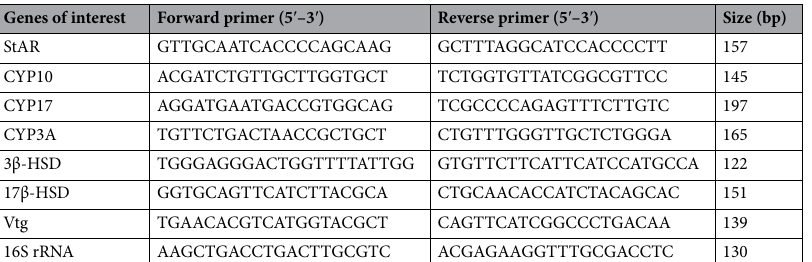
Table 1. Gene-specific primers of target genes involved in steroidogenesis, vitellogenin (Vtg), and 16S rRNA and of H. scabra and expected amplicon